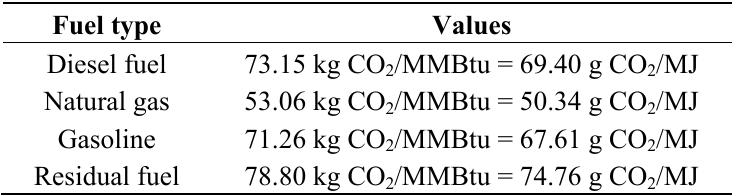
Table 2. Emission factors of various fuels used in generator (based on U.S. Energy Information Administration data